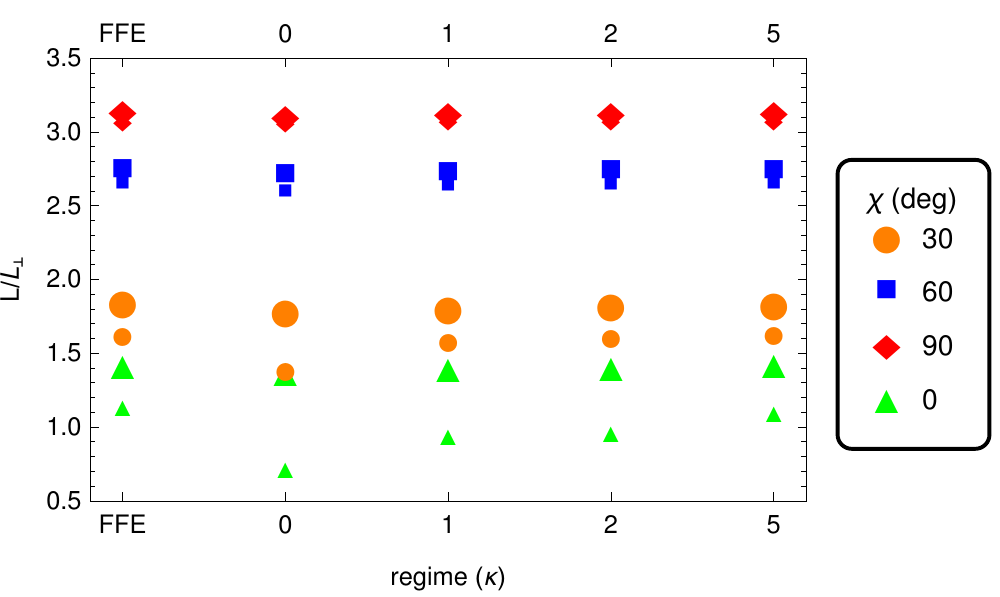
Figure 4. The Poynting flux crossing the light cylinder (larger markers) and crossing a sphere of radius 4 r L (smaller markers) for oblique rotators in force-free and radiative regimes.